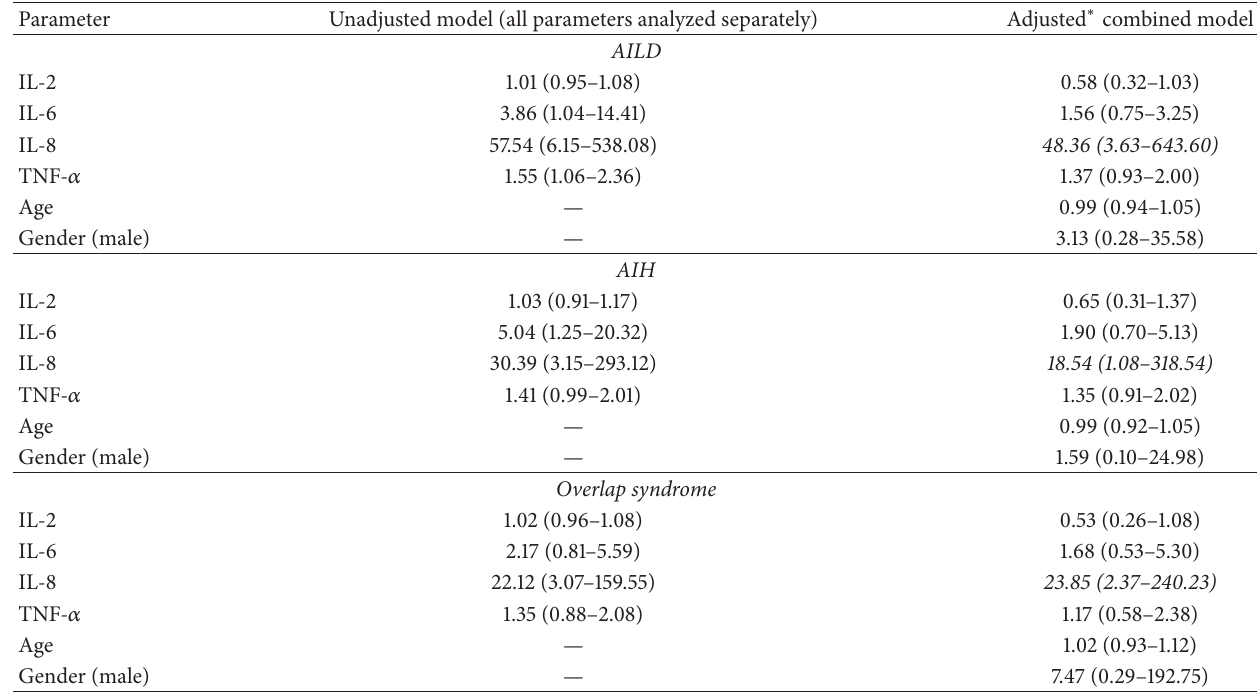
Table 3: Association (represented as odds ratios and 95% confidence intervals from the logistic regression analysis) between serum levels of cytokines (IL-2, IL-6, IL-8, and IL-10) and autoimmune liver